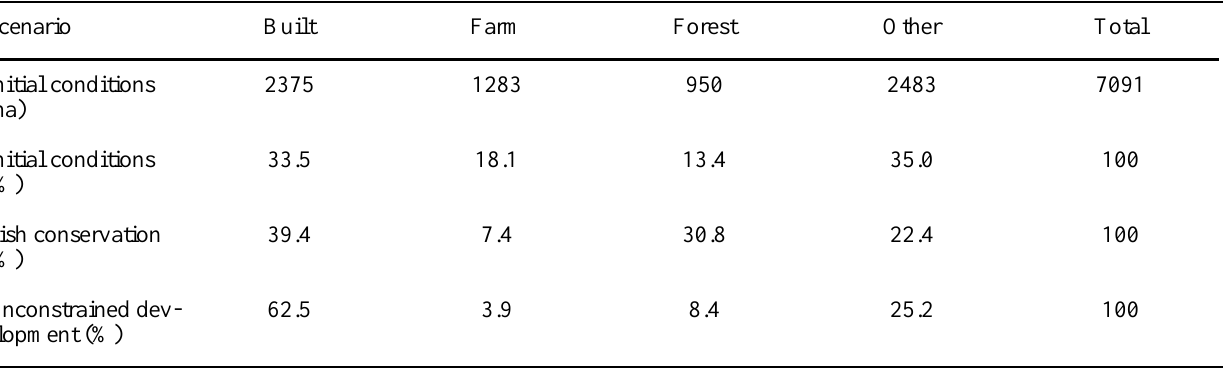
Table 2 . Distribution of land uses between initial conditions and percent land use in year 50 for fish conservation and unconstrained development scenarios. The percents are the average of 50 model runs. "Built" refers to residential, commercial, and industrial development and associated infrastructure. "Agriculture" is land in some type of agricultural land use. In addition to field crops agriculture includes nurseries, Christmas trees, fruit and berries. "Forest" is land in the forest succession categories and types. "Other" is lands like shrubland, public lands, and conservation areas not included in the built, agriculture, or forest